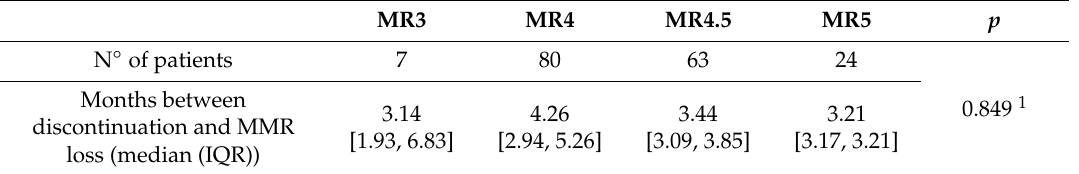
Table 2. Depth of molecular remission at discontinuation and time to MMR loss. MR3 MR4 MR4.5 MR5 p N ◦ of